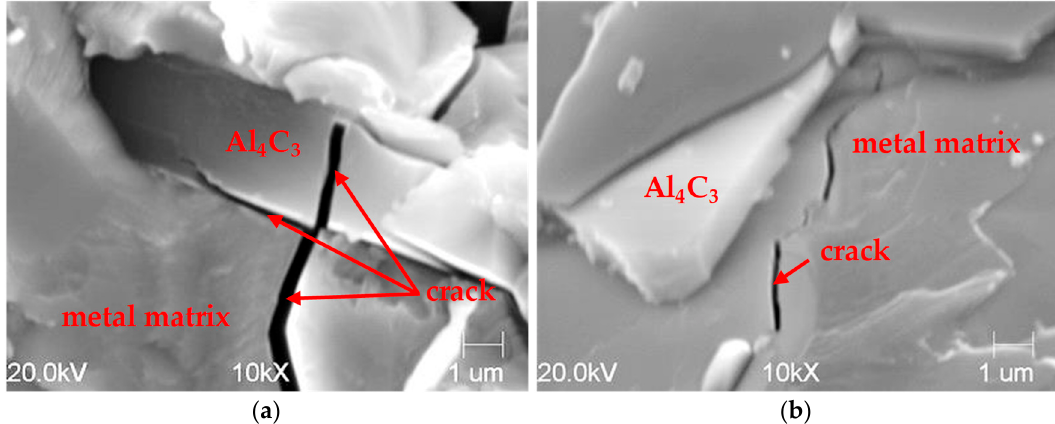
Figure 6. Sample fracture made of high-aluminum cast iron; SEM microstructure—magnification 1000× ( a ), 4000× ( b ).